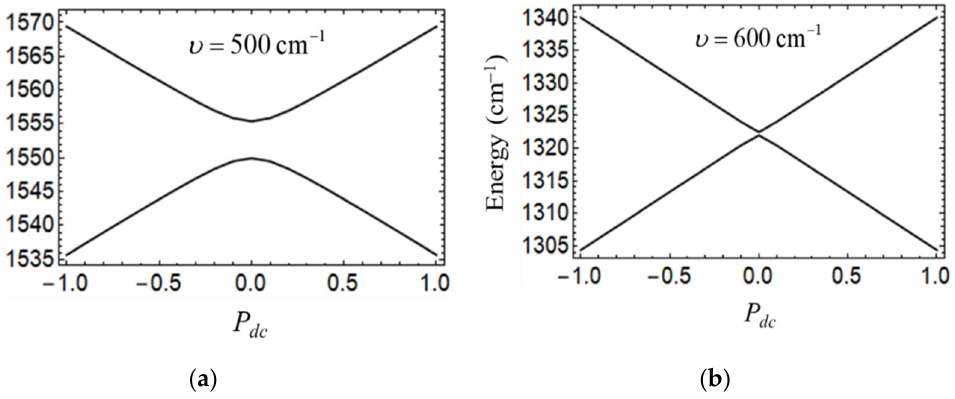
Figure 7. Dependences of the ground and the first excited vibronic levels of the working cell on the driver-cell polarization P dc evaluated for two values of the vibronic coupling parameter υ : ( a ) υ = 500 cm − 1 ; ( b ) υ = 600 cm − 1